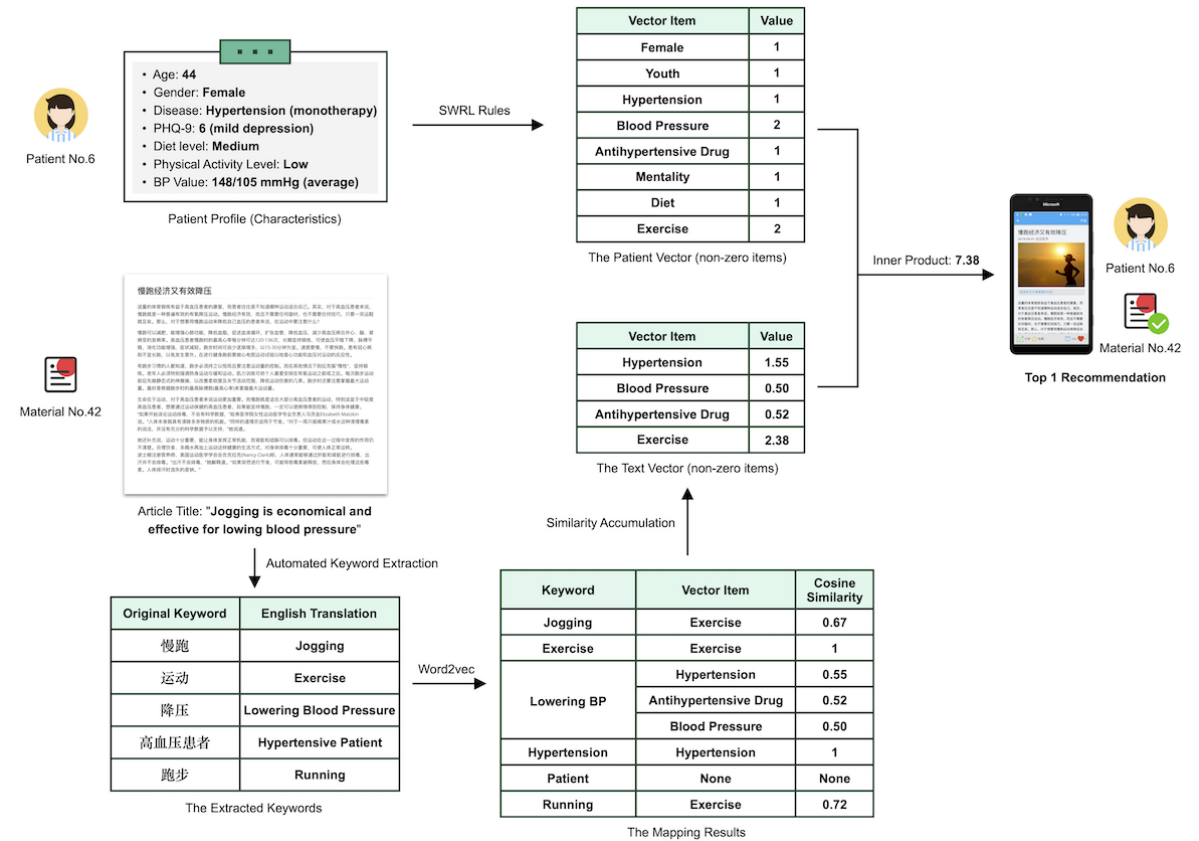
Figure 11. Complete scenario for the recommendation generation process.